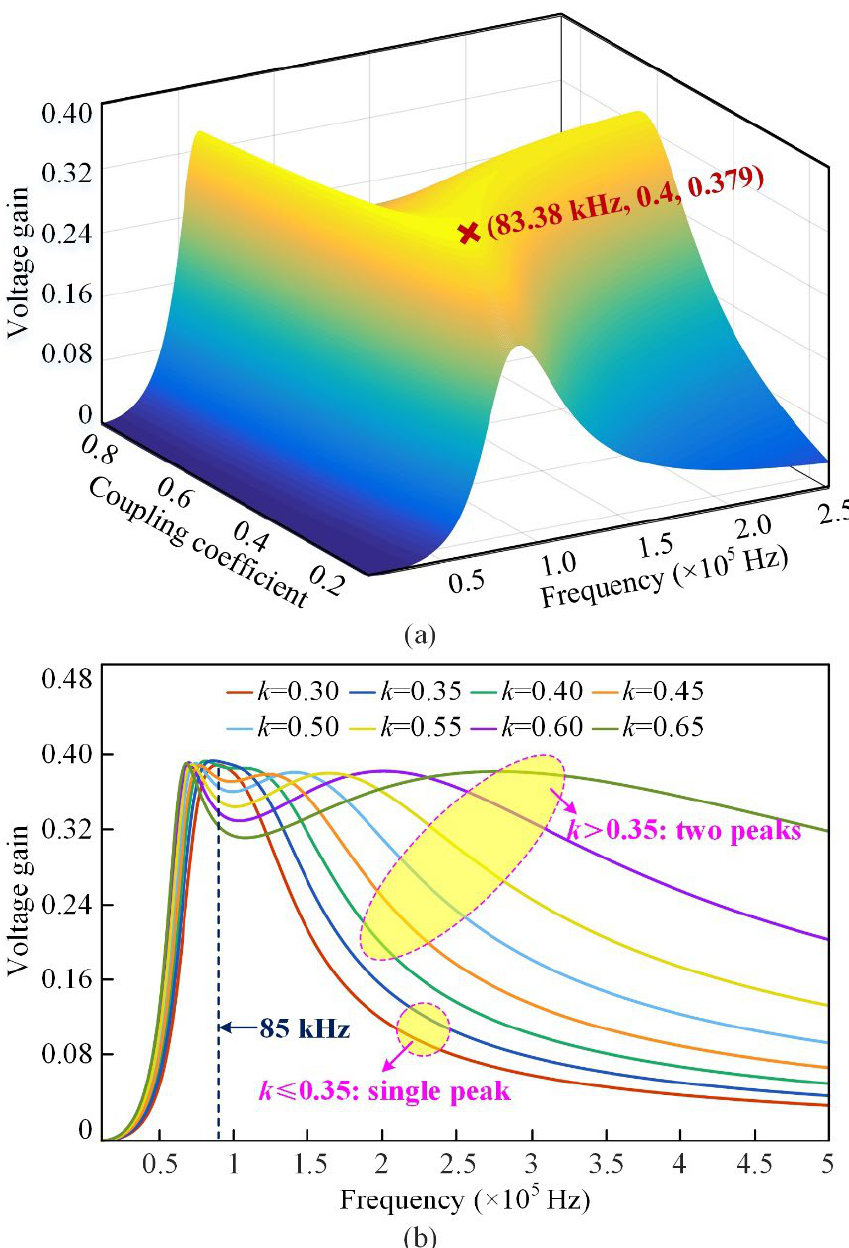
Figure 6. ( a ) Voltage gain ( U L / U S ) as a function of Tx-to-Rx coupling coefficient and operating frequency; ( b ) 2D curve of voltage gain in loosely coupled and over-coupled regions, respectively.